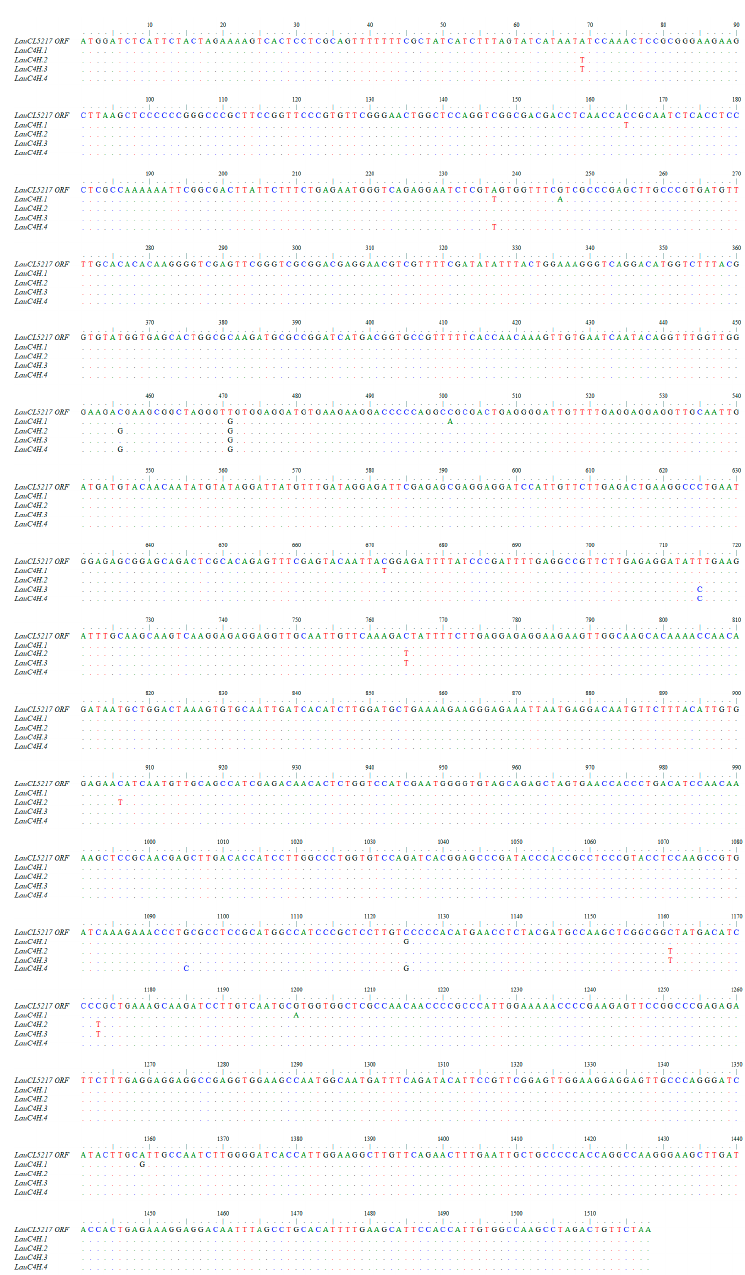
Figure A1. Coding sequence alignment of Lau C4H variants. Four unique variants of Lau C4H gene are aligned against the original sequence predicted by the de novo assembled transcriptome. Dots are identical bases.